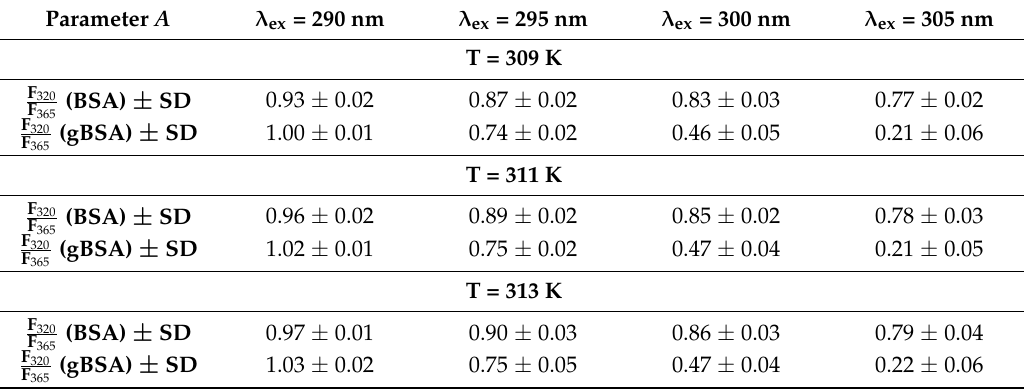
Table 1. The fluorescence intensity of BSA and gBSA at λ em = 320 nm and λ em = 365 nm; λ ex = 290 nm, λ ex = 295 nm, λ ex = 300 nm and λ ex = 305 nm; BSA, gBSA = 5 × 10 − 6 mol · L − 1 ; T = 309 K, T = 311 K and T = 313 K.